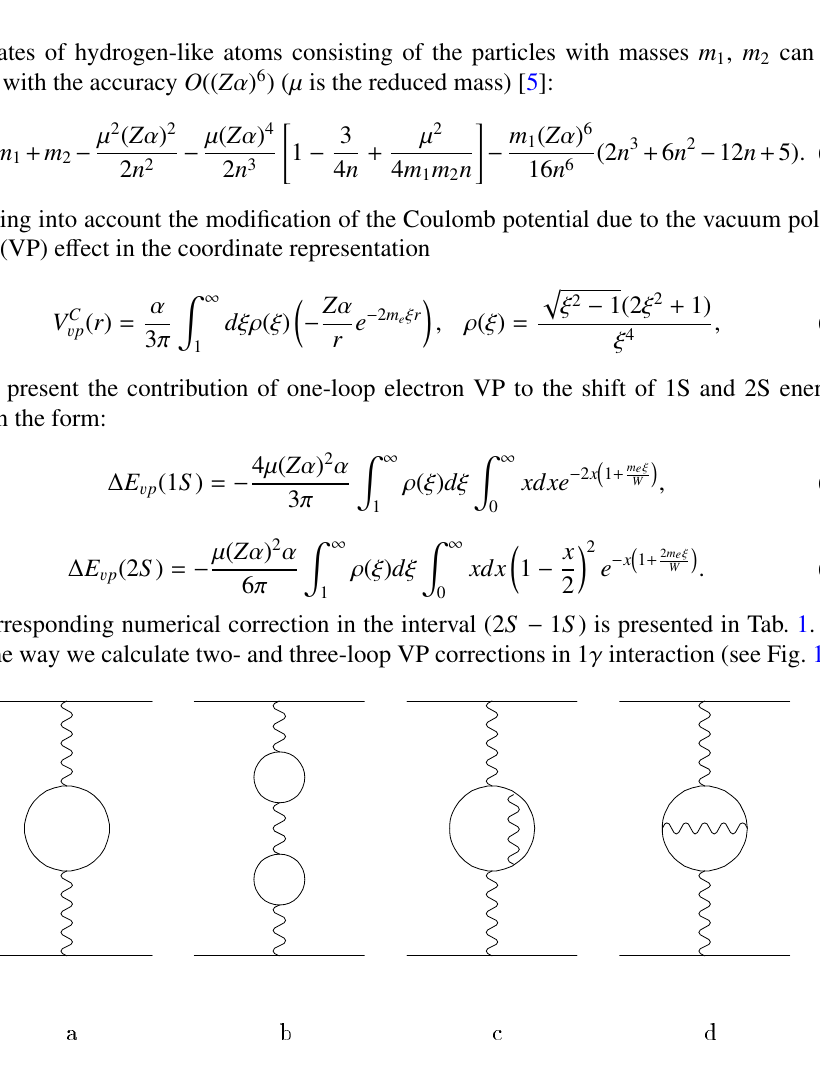
Figure 1. The e ff ects of one-loop, two-loop vacuum polarization in one-photon